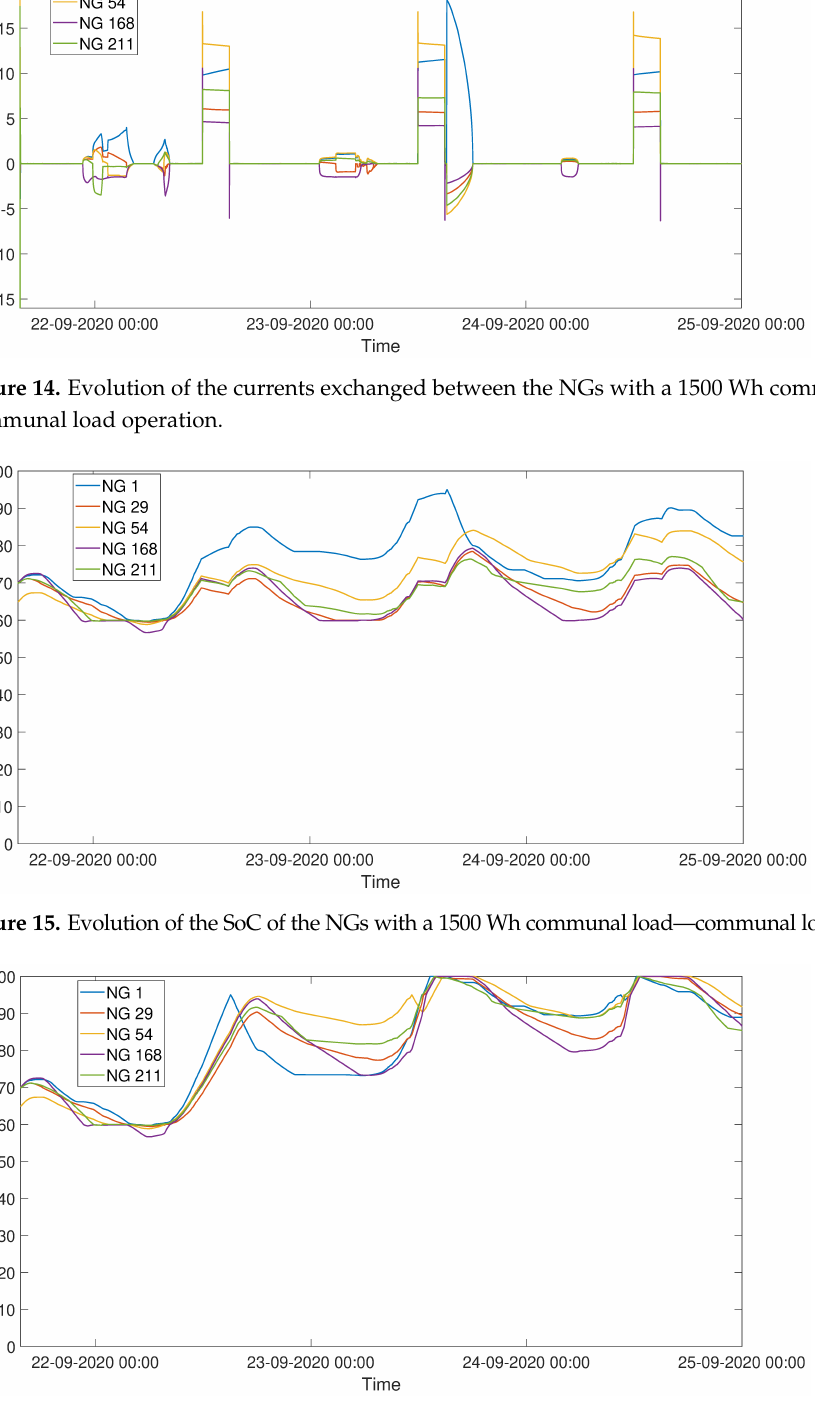
Figure 16. Evolution of the SoC of the NGs without a communal